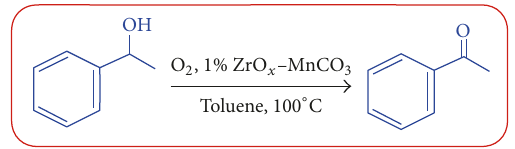
on the oxidation of 1-phenylethanol. [ a x